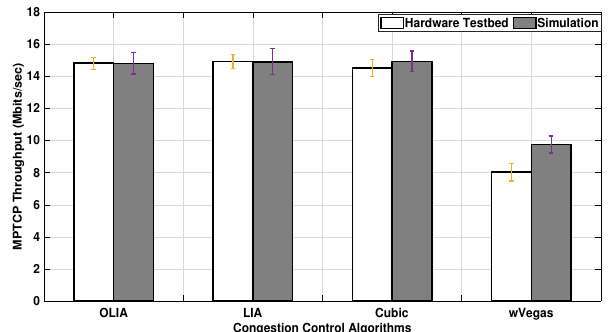
Figure 9. Setup 1 Downlink MPTCP Throughput.